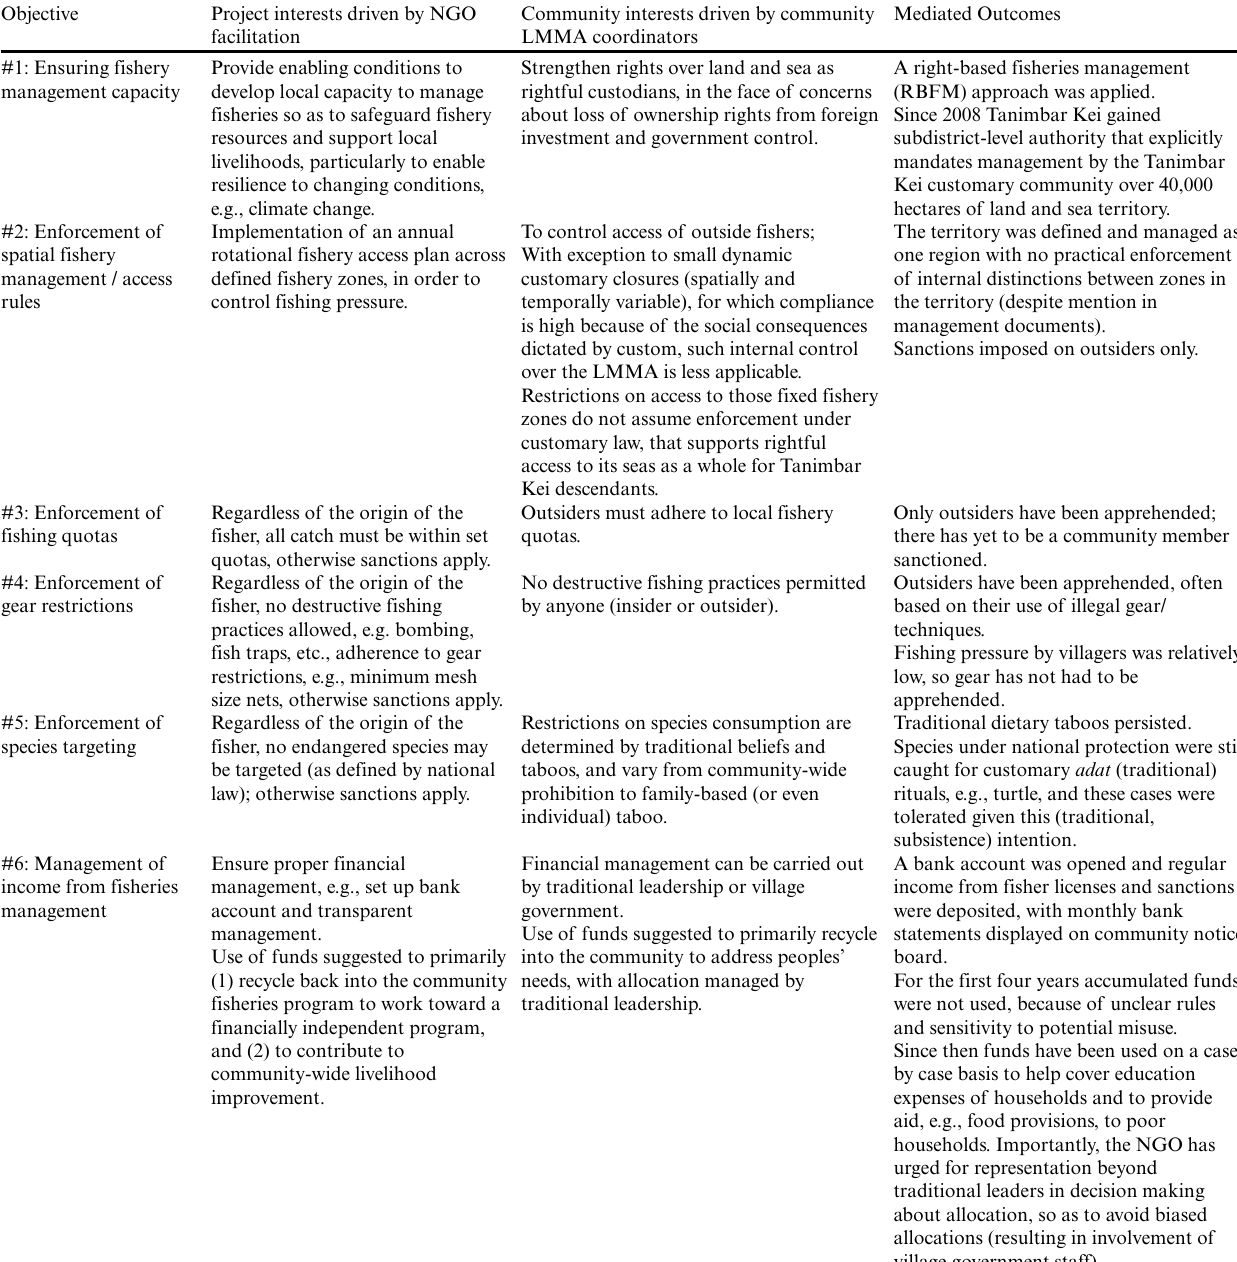
Table 1 . Overview of mediated program outcomes resulting from differentiated interests between technical facilitating staff and the community representatives as part of a locally managed marine area (LMMA) program in Tanimbar Kei, eastern Indonesia. Fisheries management objectives developed to escape the social-ecological trap appear in the furthest right